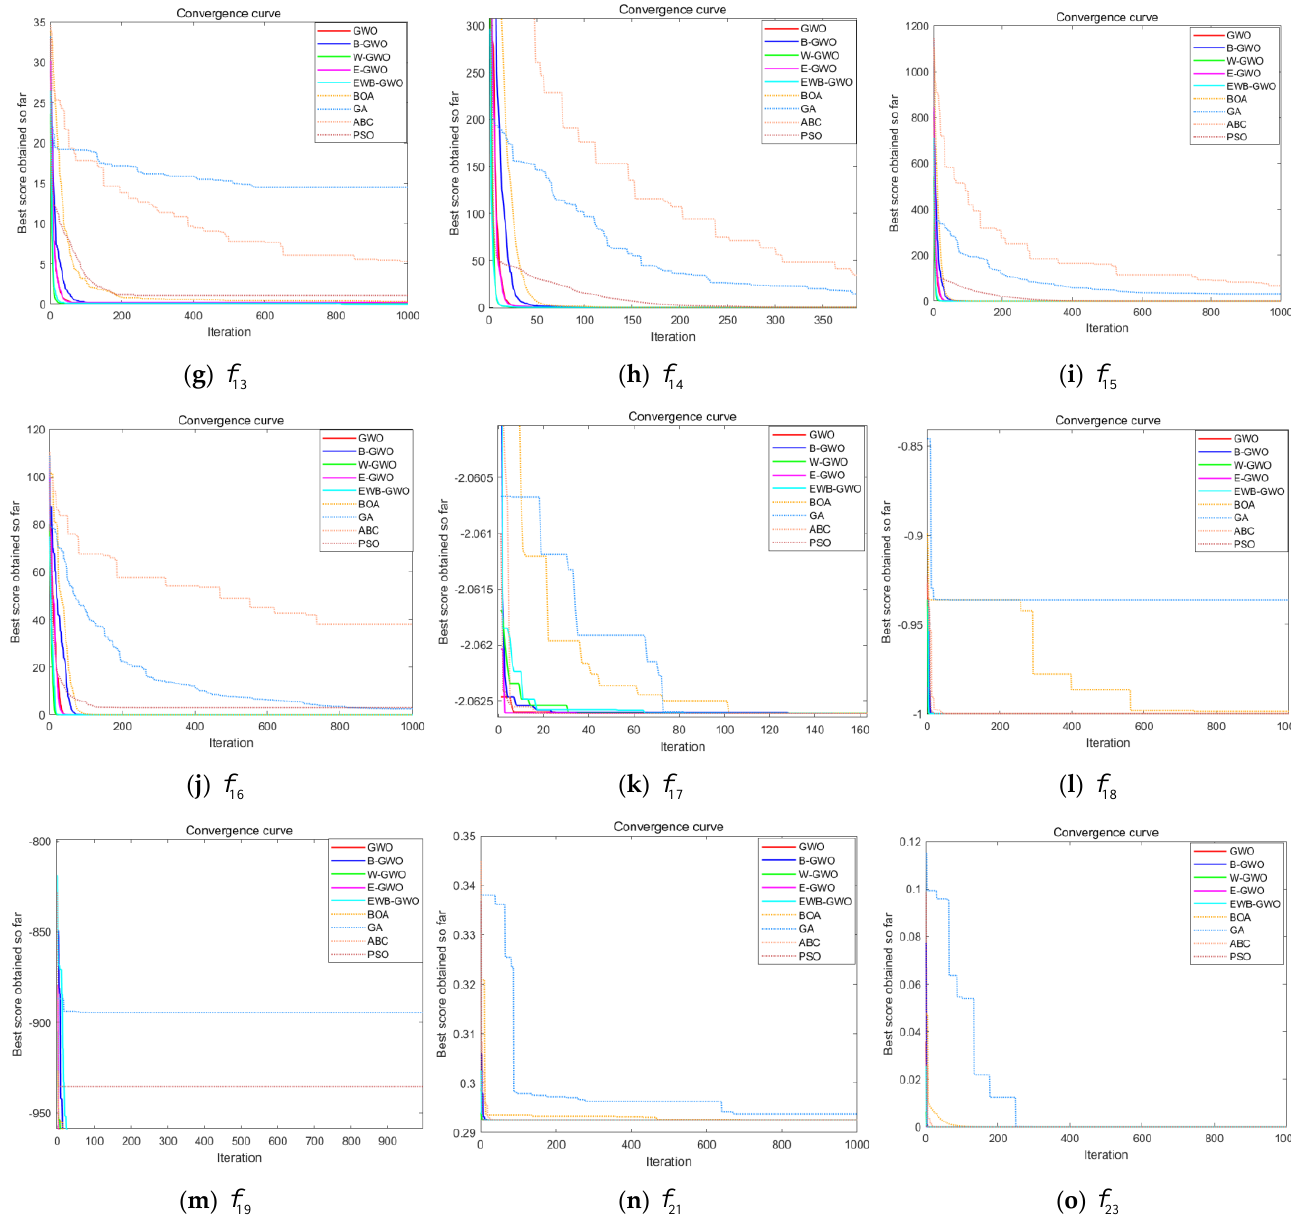
Figure 14. Comparison of convergence curves of GWO, B − GWO, W − GWO, E − GWO, EWB − GWO, GA, PSO, BOA, and ABC.